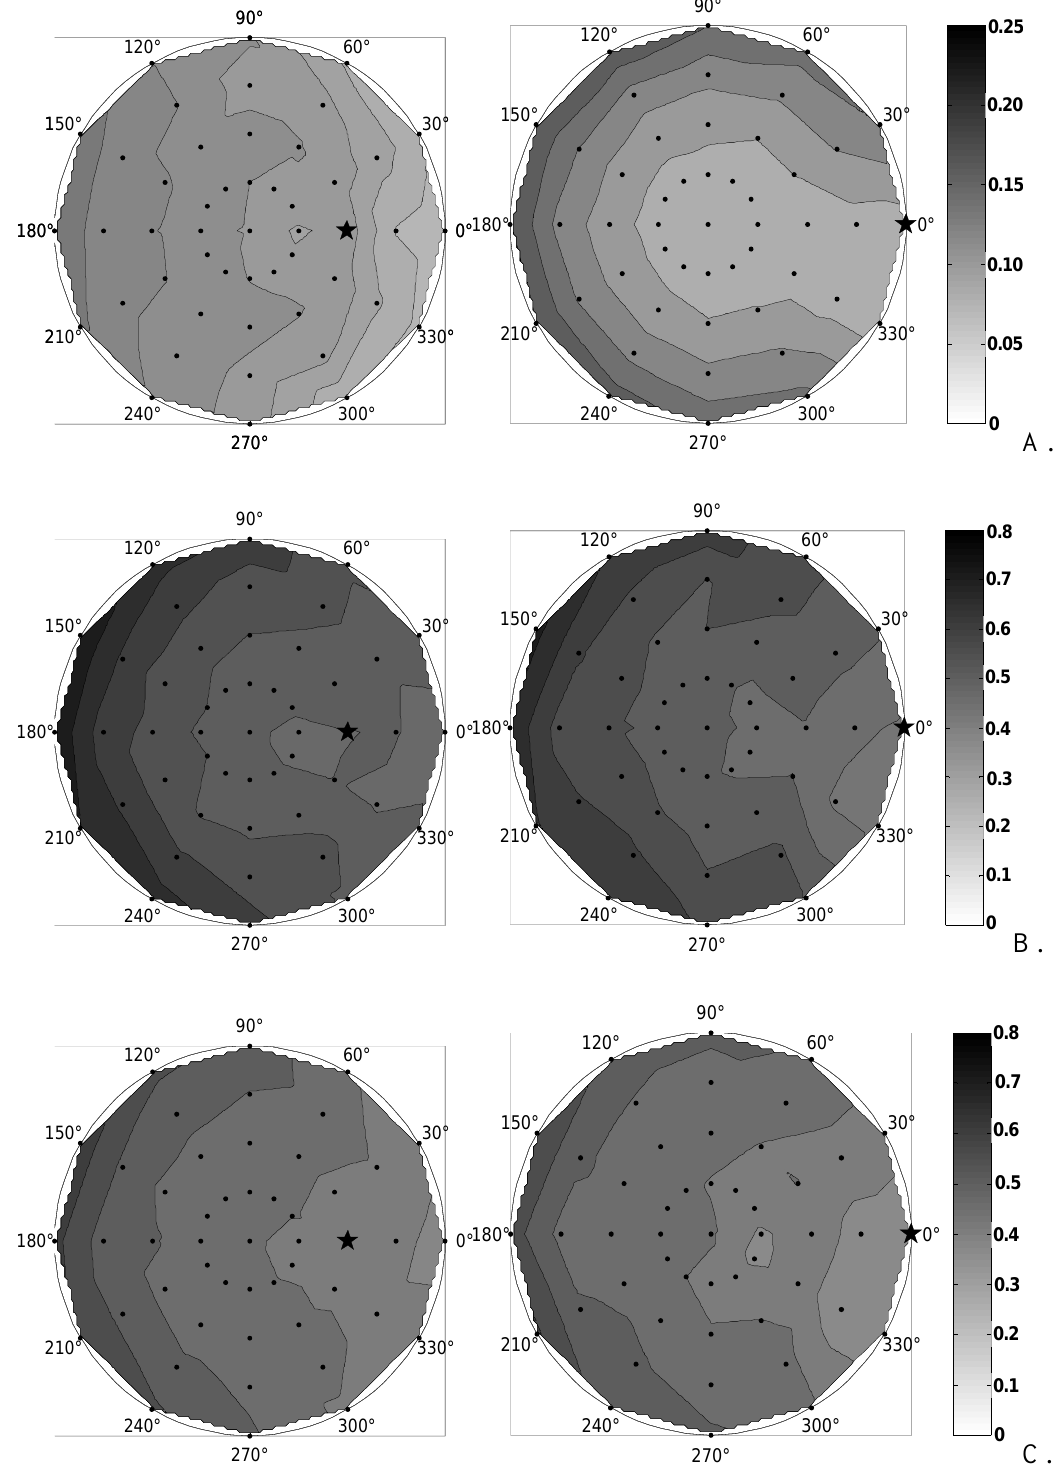
Figure 6 . Bidirectional Reflectance Factor of a Fagus sylvatica L. leaf at 550 nm (A), 850 nm (B) and 1650 nm (C), for light source position set at 0° azimuth and 30° zenith (left) and at 0° azimuth and 60° zenith (right). The sensor is azimuthally positioned all over the hemisphere and ranges in zenith between 0° and 60°, with 15° increments. Sensor’s positions are marked by dots, while incident direction is presented by a star. The bar scale indicate reflectance